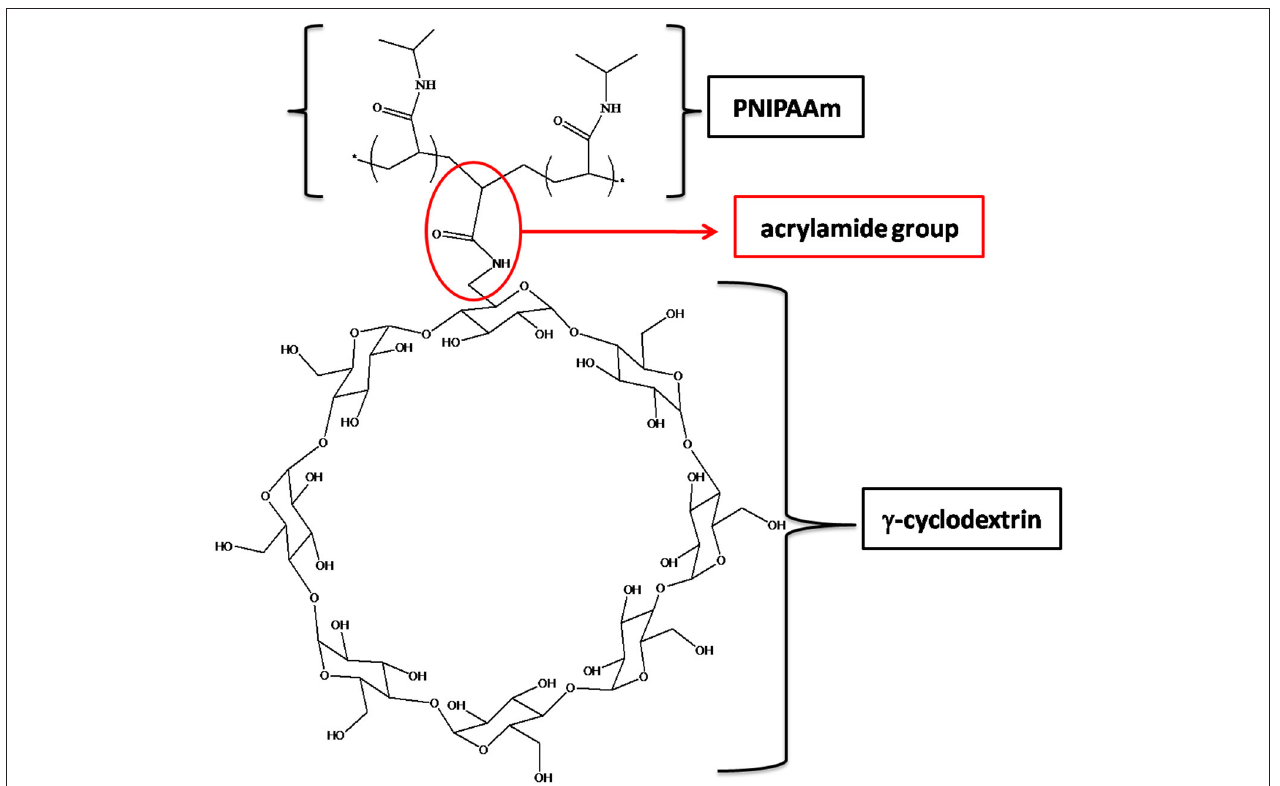
FIGURE 1 | Structure of A γ CD linked to a PNIPAAm macromolecular chain.